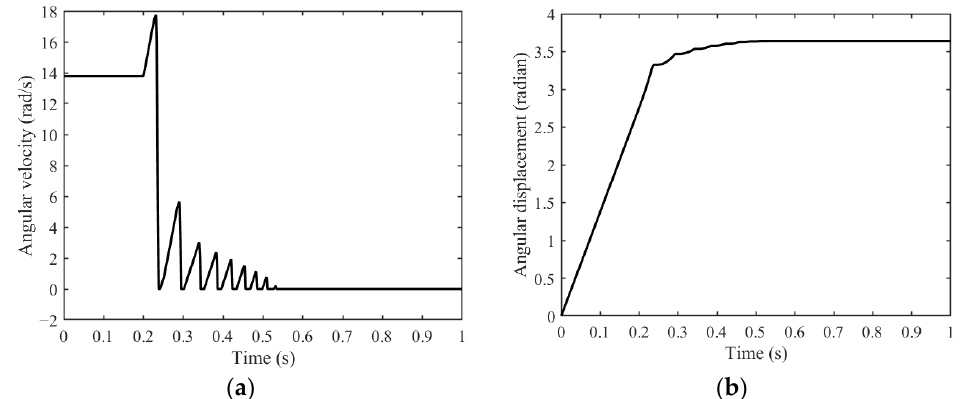
Figure 15. Dynamic features of output shaft under forward load. ( a ) Angular velocity. ( b ) Angular